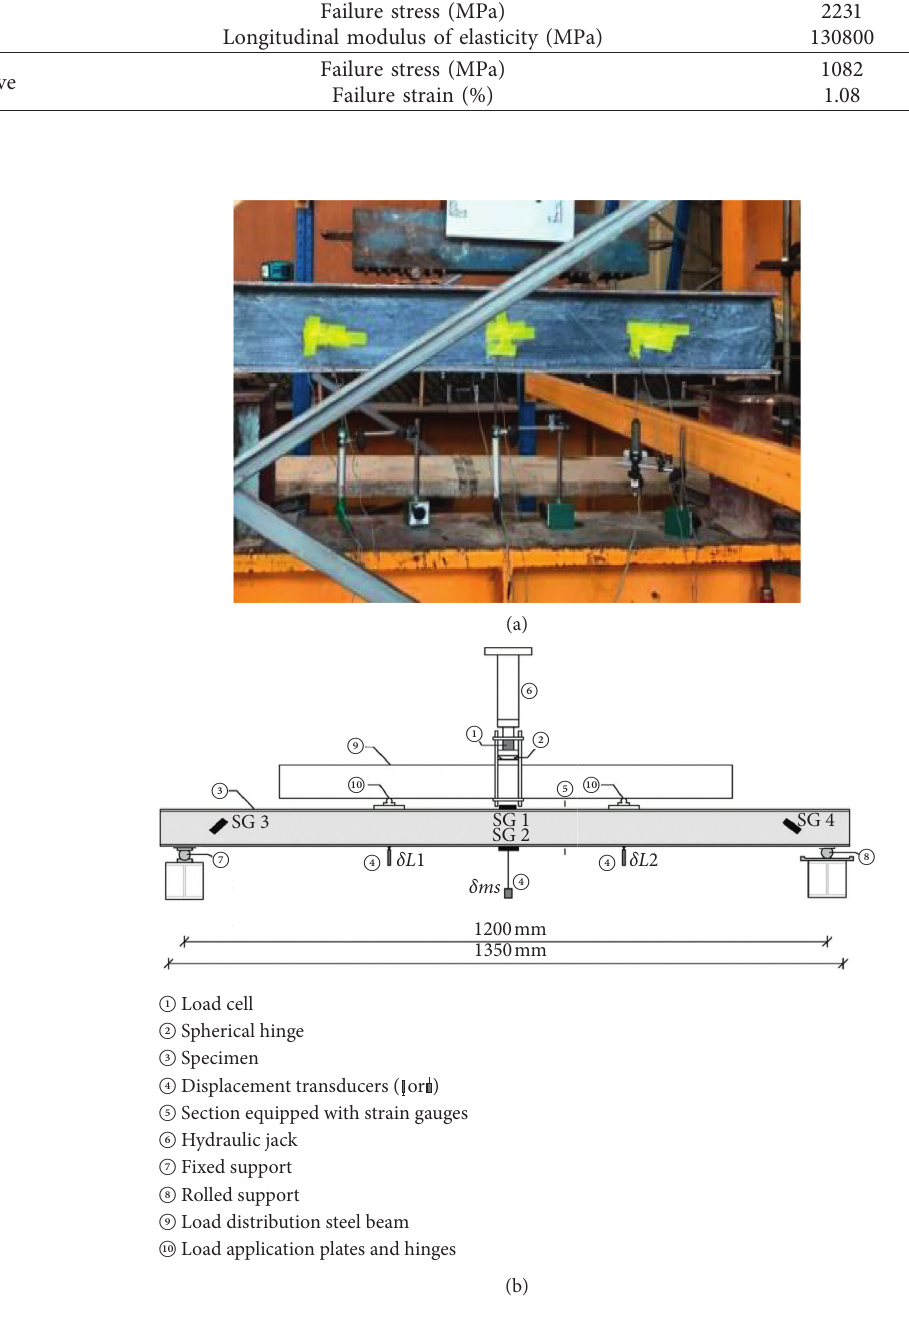
Figure 4: (a) Setup of testing and (b) details and locations of strain